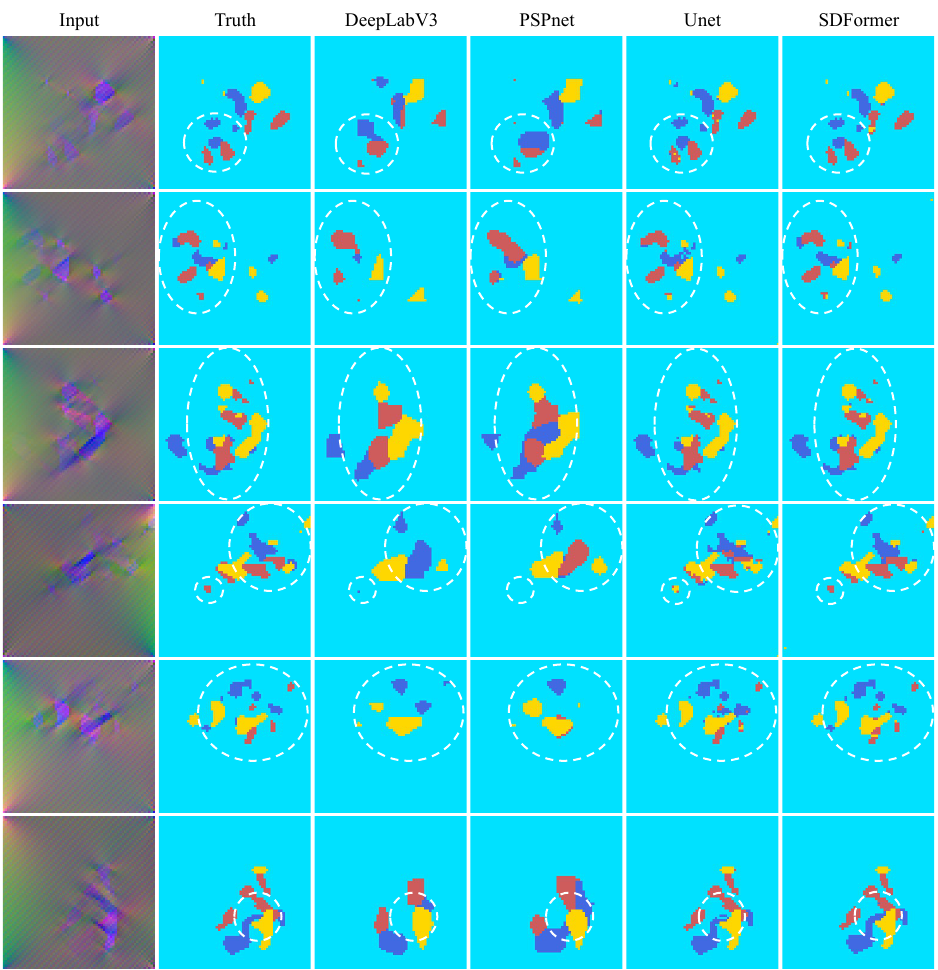
Figure 10. Test result of DeepLabV3, PSPnet, UNet, and SDFormer on the plate dataset.